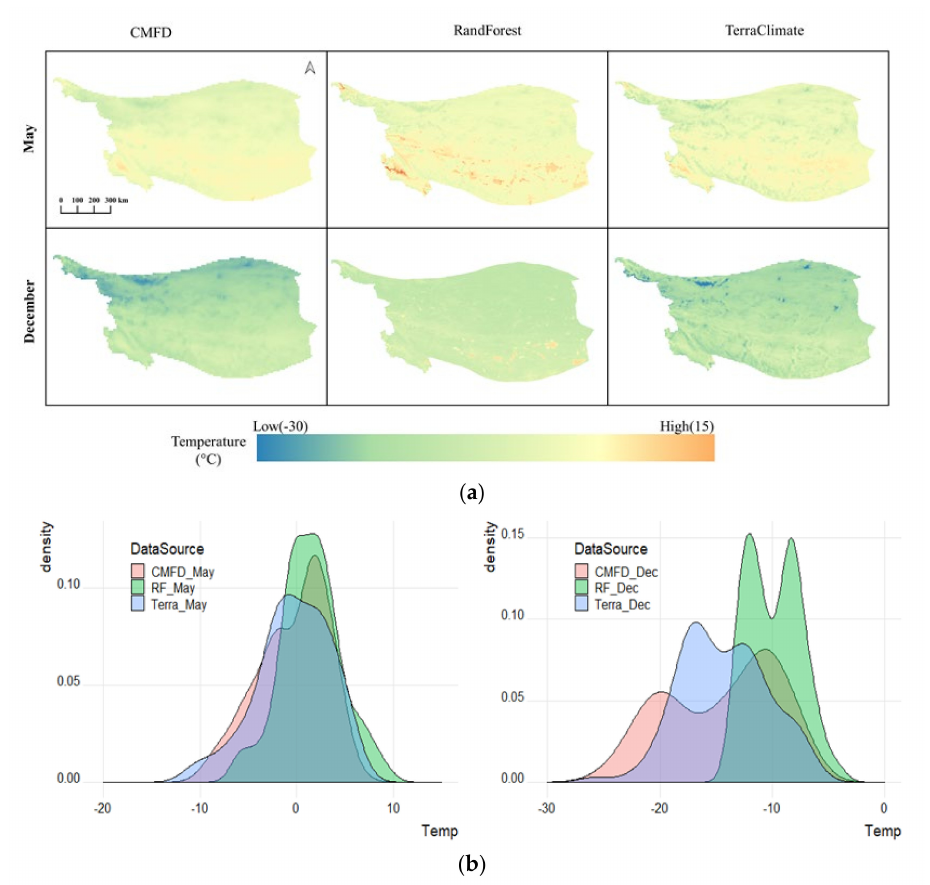
Figure 9. ( a ) Spatial average maps and ( b ) histograms of Tmean in 2003–2013 at Central TP for May and